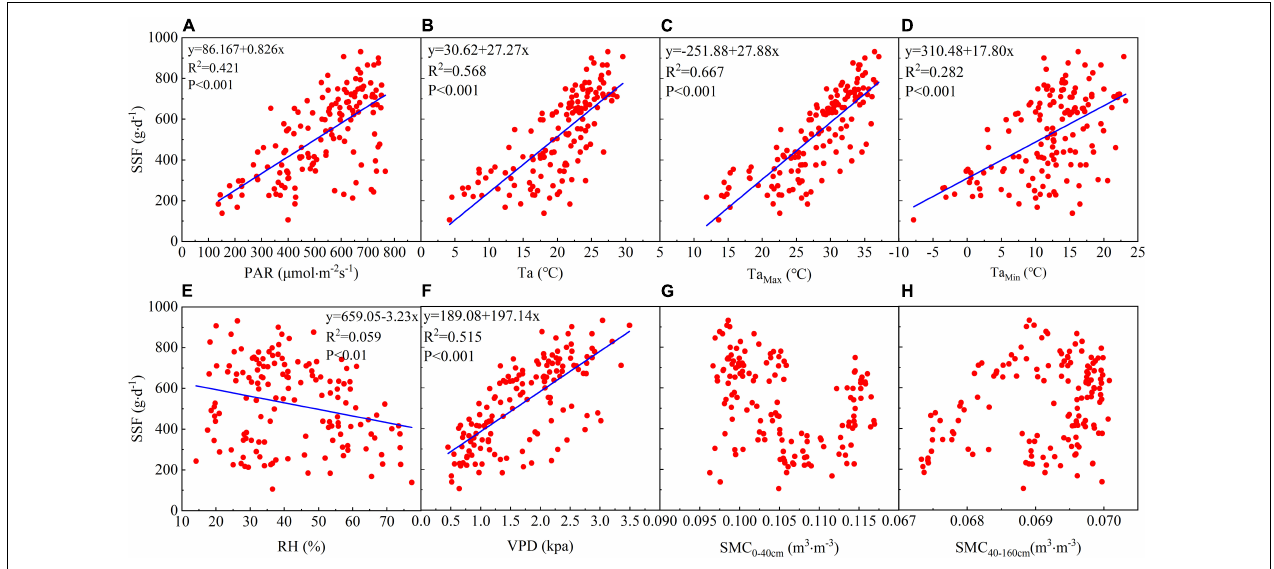
FIGURE 4 | The relationship between the daily SSF and eight environmental factors: (A) PAR, (B) Ta Ave , (C) Ta Max , (D) Ta Min , (E) RH, (F) VPD, (G) soil moisture content